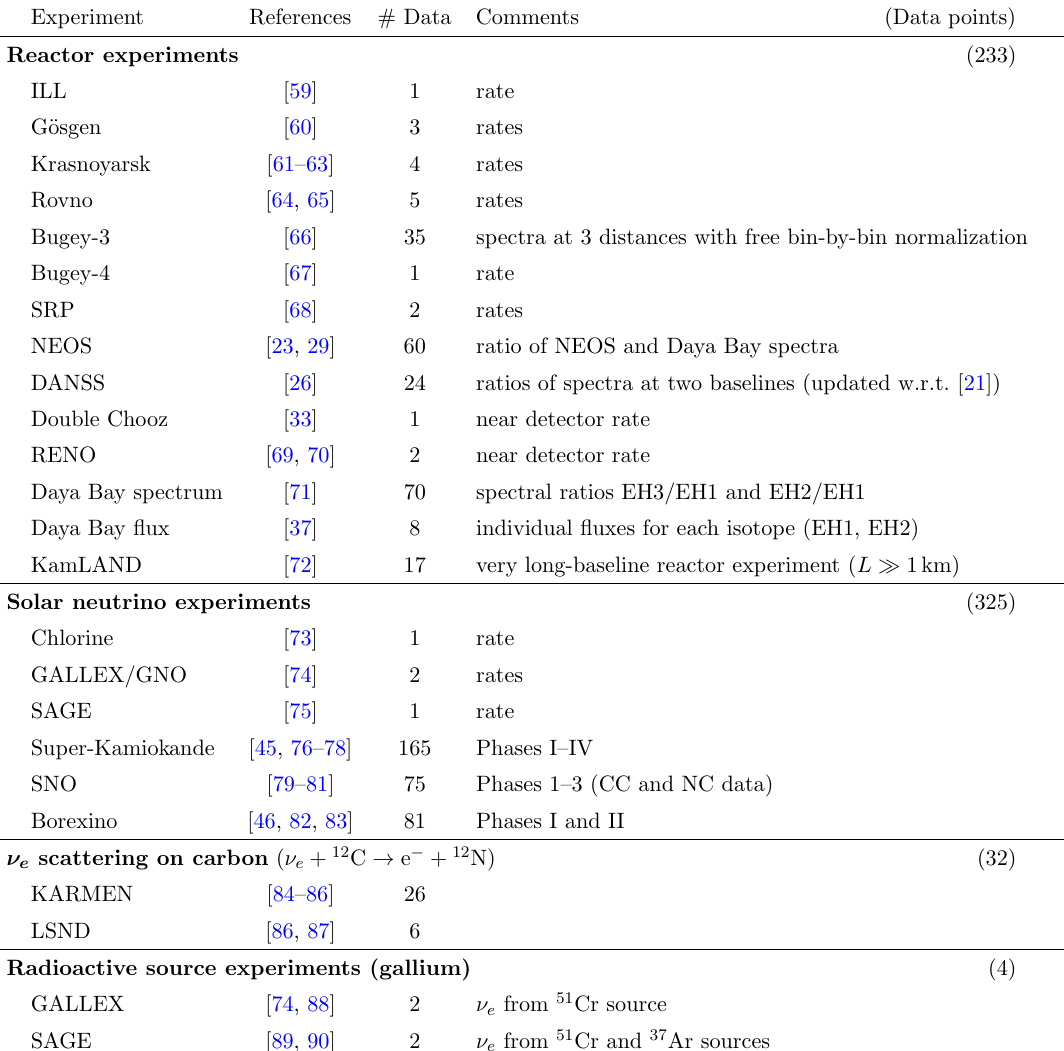
Table 1 . Data sets included in our (cid:23) e /(cid:22) (cid:23) e disappearance analysis. The total number of data points is 594. More details can be found in ref. [21]; the only update with respect of [21] is new data from DANSS